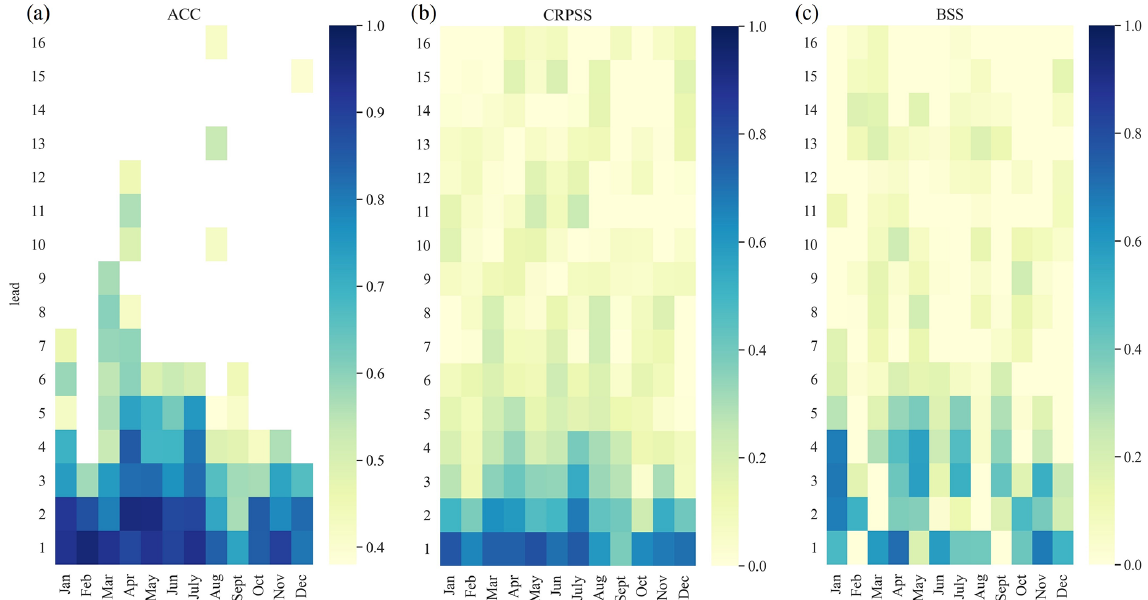
Figure 7. Heatmaps of weekly ACC (same as in Fig. 6), CRPSS, and BSS for discharge hindcasts (RF model) of the example station Hagenstein Boven for different initialization months. Cells in blue, for (a) ACC, (b) CRPSS and (c) BSS, indicate a good performance. For (b) CRPSS and (c) BSS, values above 0 indicate that the hybrid framework is outperforming the climatological reference.